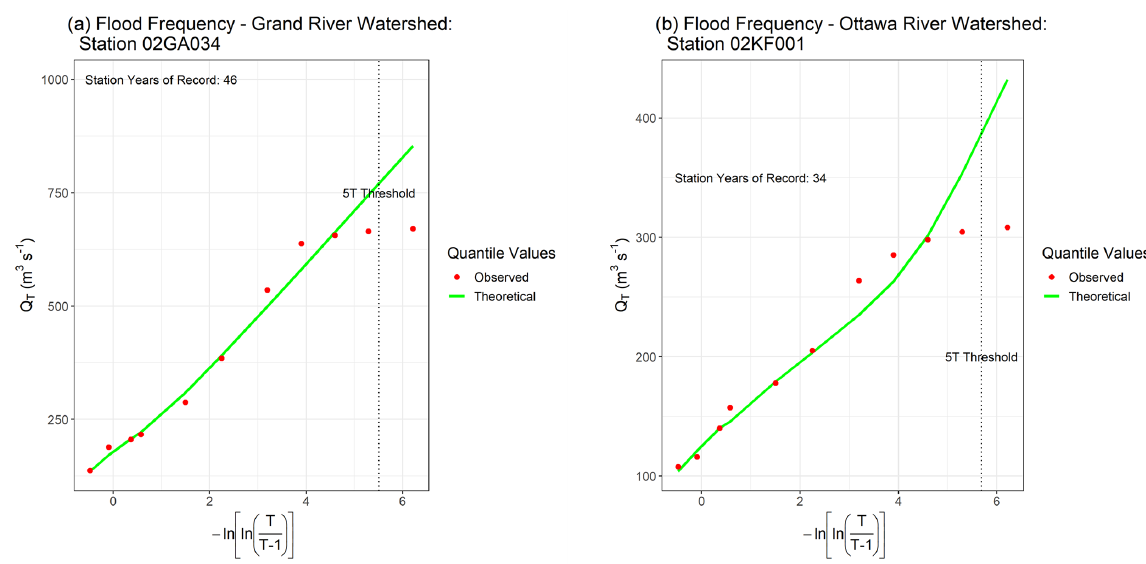
Figure 5. Theoretical vs. estimated flood